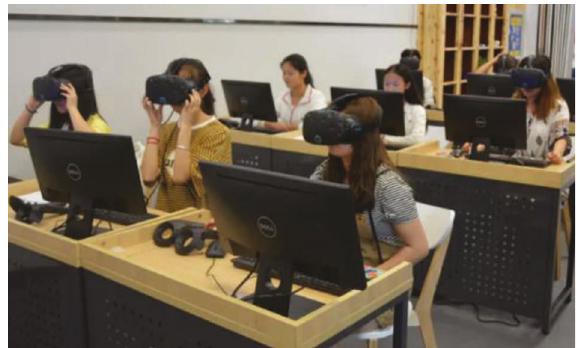
Figure 1: The VR